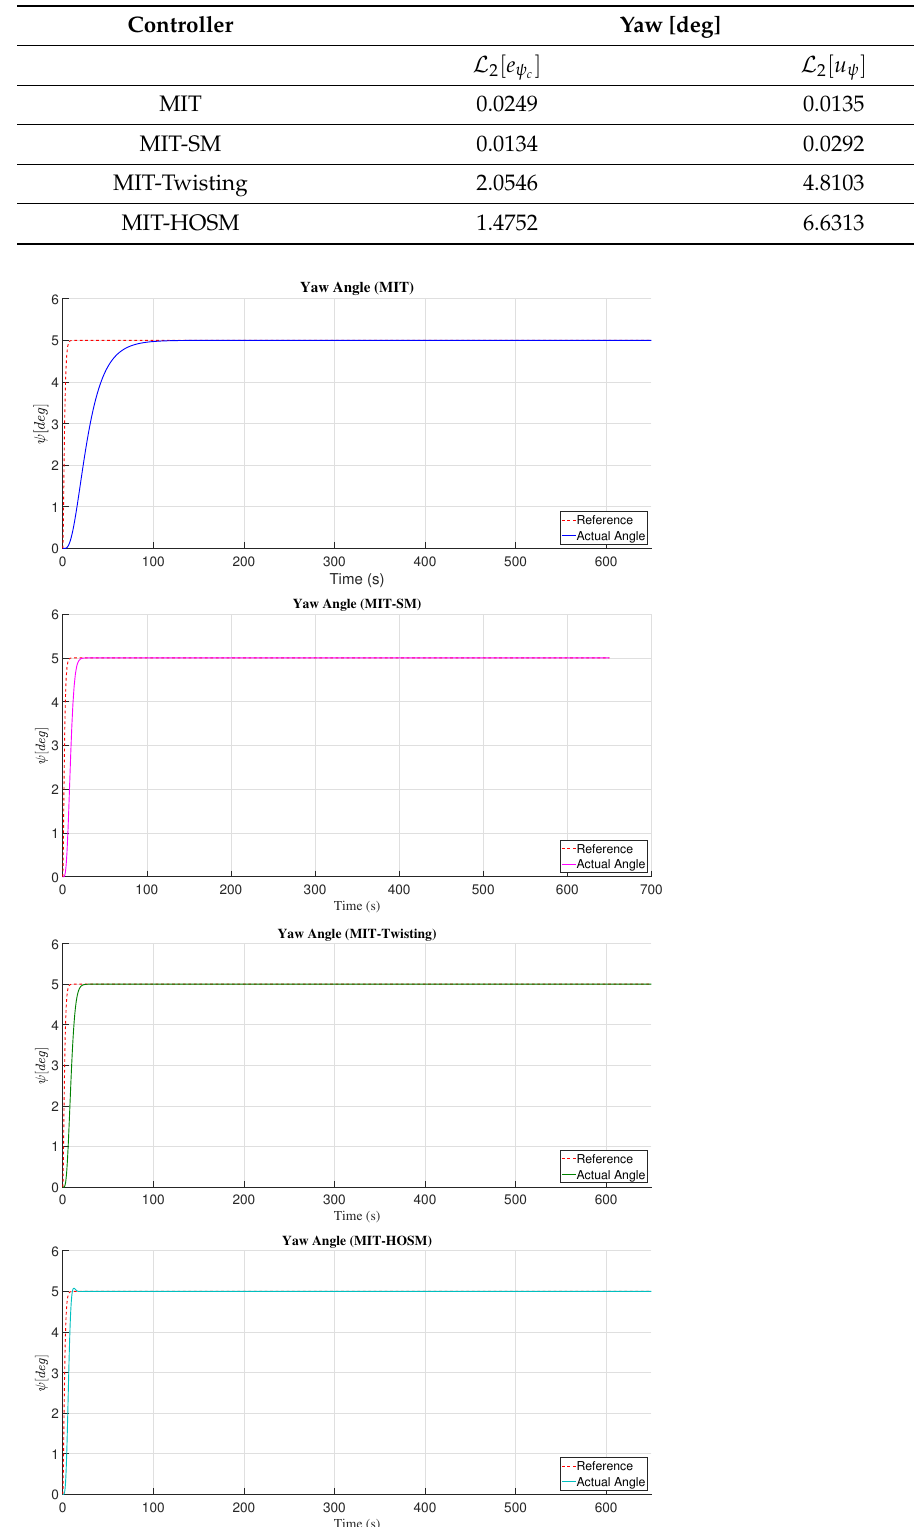
Figure 10. Yaw angle